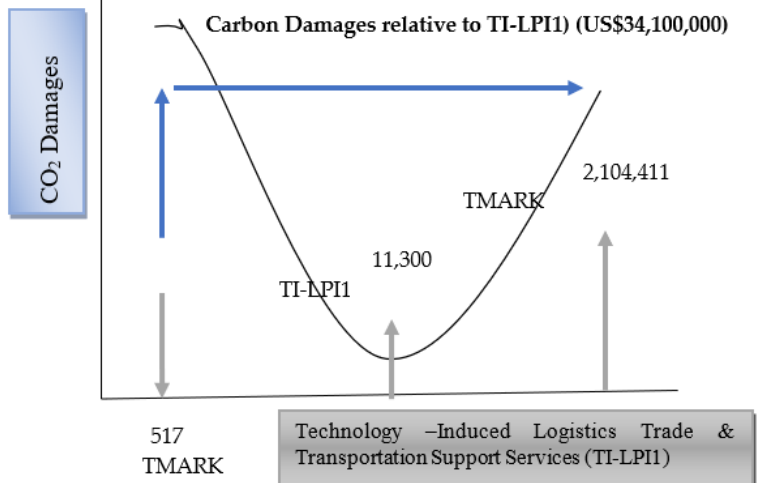
Figure 8. Moderation U-shaped Curve between Carbon Damages and Technology Induced Logistics Performance Indices (LPI1 × TMARK).